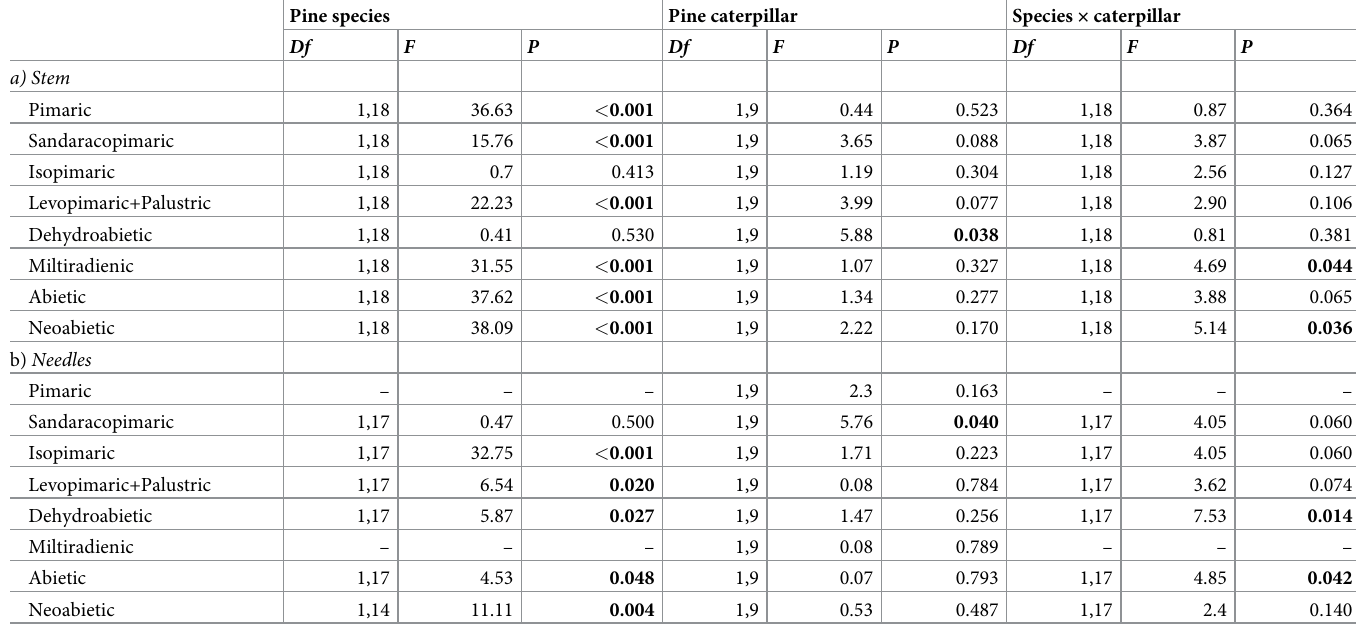
Table 4. Effects of the pine caterpillar feeding on the concentration of the main resin acids in the stem (a) and in the needles (b) tissues of two pine